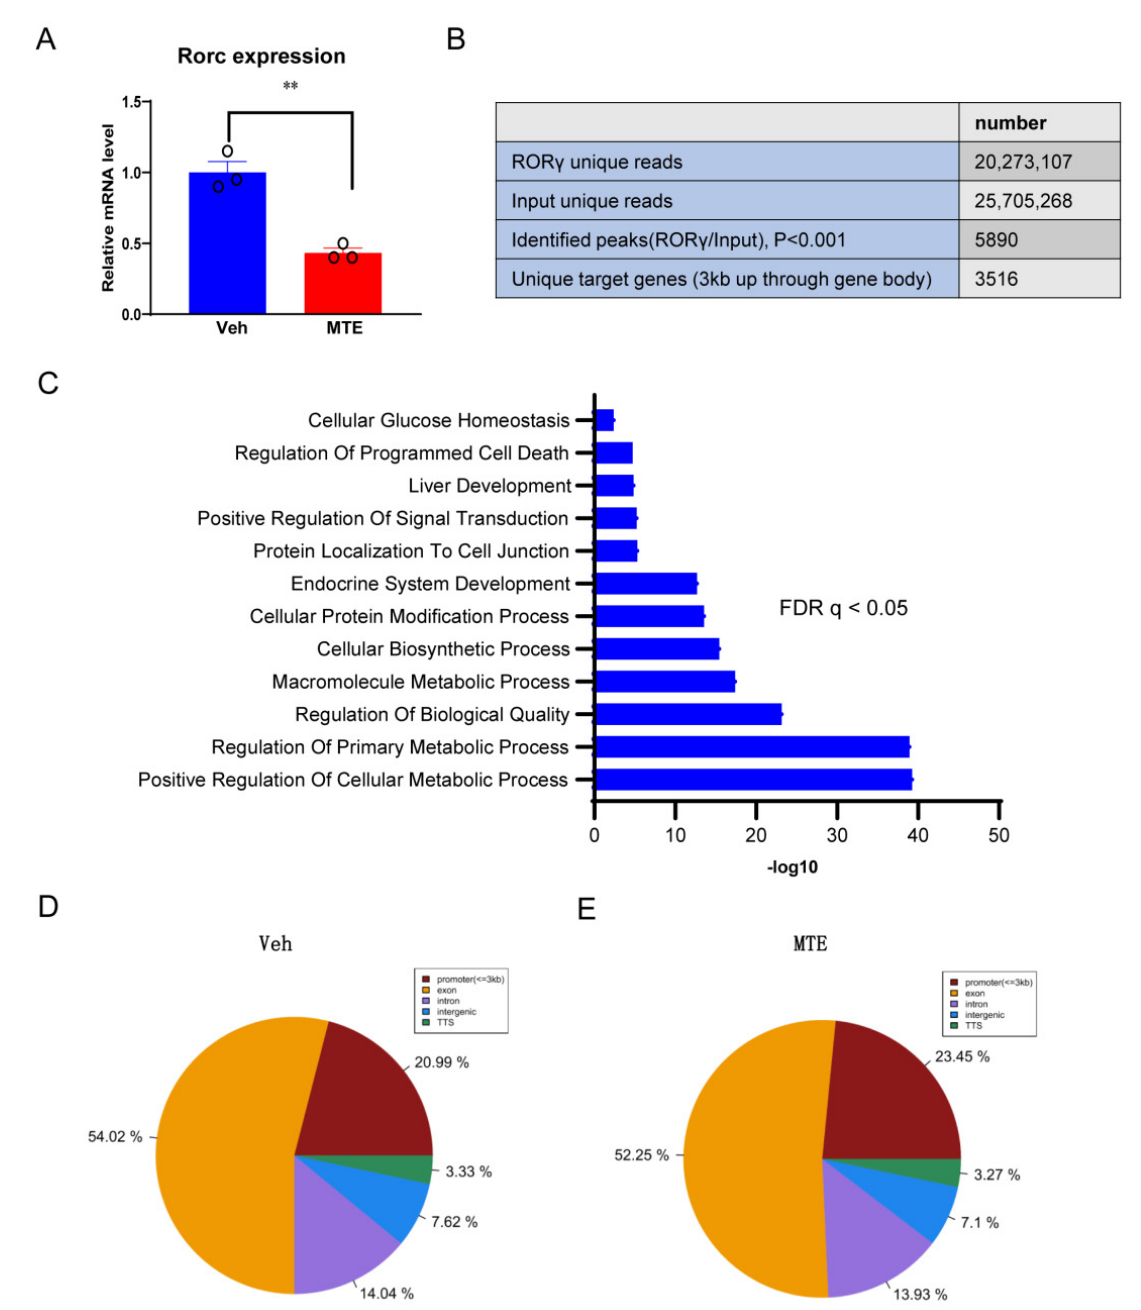
Figure 4. Genome-wide ChIP-seq analysis of ROR γ enrichments in piglet liver. ( A ) ROR γ gene mRNA analyzed by qRT-PCR in control or mycotoxin-exposed piglet liver. ( B ) Summary of ROR γ ChIP-Seq analysis and porcine liver chromatin. ( C ) GO analysis of ROR γ ChIP-seq peak-linked genes. ( D , E ) The binding sites were localized within intergenic regions, introns, exon, transcriptional start site (TSS), and within a 3 kb region of the promoter in the livers.